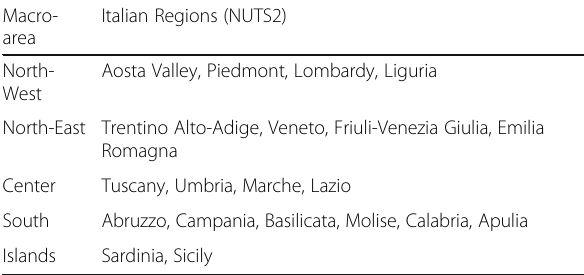
Table 5 the macro-areas of the national